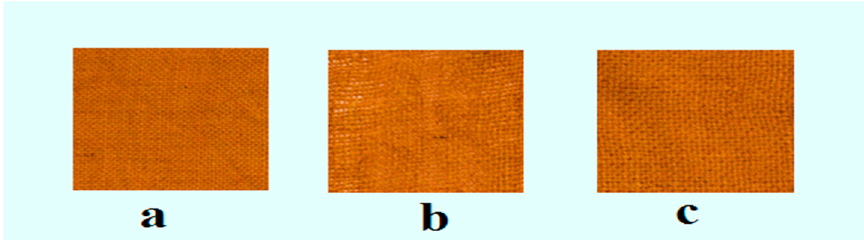
Figure 2. Woven-jute fibre of grades ( a ) 250 gsm, ( b ) 300 gsm and ( c ) 350 gsm.